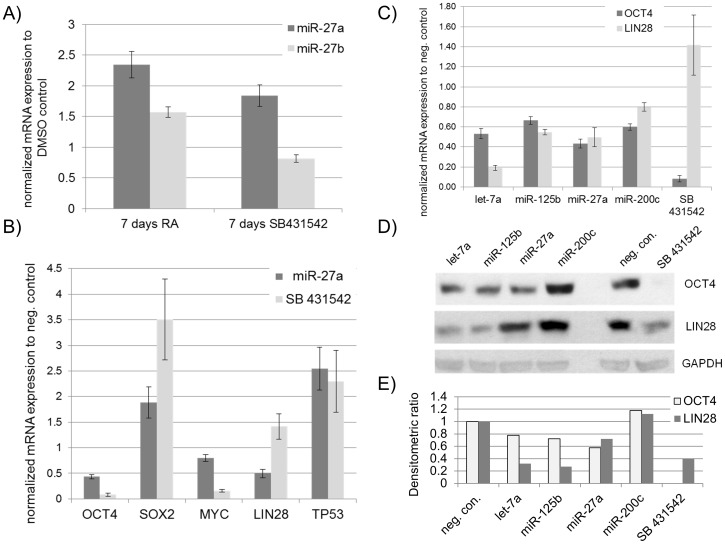
miR-27 inhibits OCT4 and LIN28 expression at both the transcriptional and translational level in embryonal carcinoma cells (NCCIT).(A) Analysis of miR-27 expression was carried out for miR-27a and miR-27b using TaqMan-based PCR on total RNA samples isolated from NCCIT cells undergoing RA stimulated neuronal differentiation for seven days or by blocking TGFßR2 with SB431542 for seven days and normalized to the DMSO-treated control. (B) qRT-PCR of selected genes (log2-fold change relative to the negative control) was validated for NCCIT cells transfected once with miR-27 or treated with SB431542 for 48 h. NCCIT cells transfected with a scrambled miRNA mimic was used for normalization. (C) Relative OCT4 and LIN28 expression in NCCIT cells transfected with scrambled negative control miRNA mimics, let-7a, miR-125b, miR-27a, miR-200c or treated with SB431542 for 72 h and validated by qRT-PCR. (D) Western Blot analysis of OCT4 and LIN28 expression in NCCIT cells treated as described in (C). (E) Normalized densitometric-derived ratios of Western Blot presented in (D).